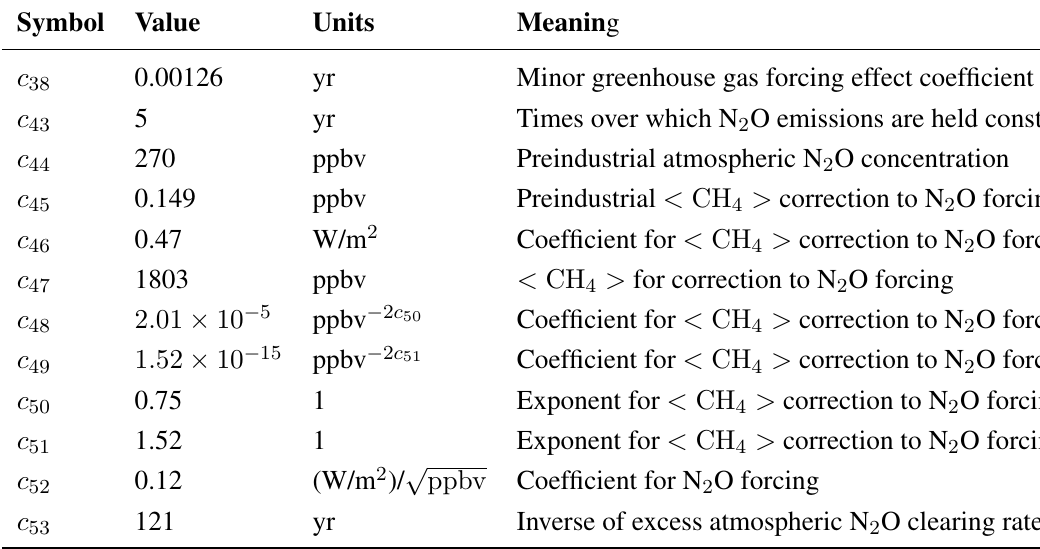
Table 4. Global nitrous oxide